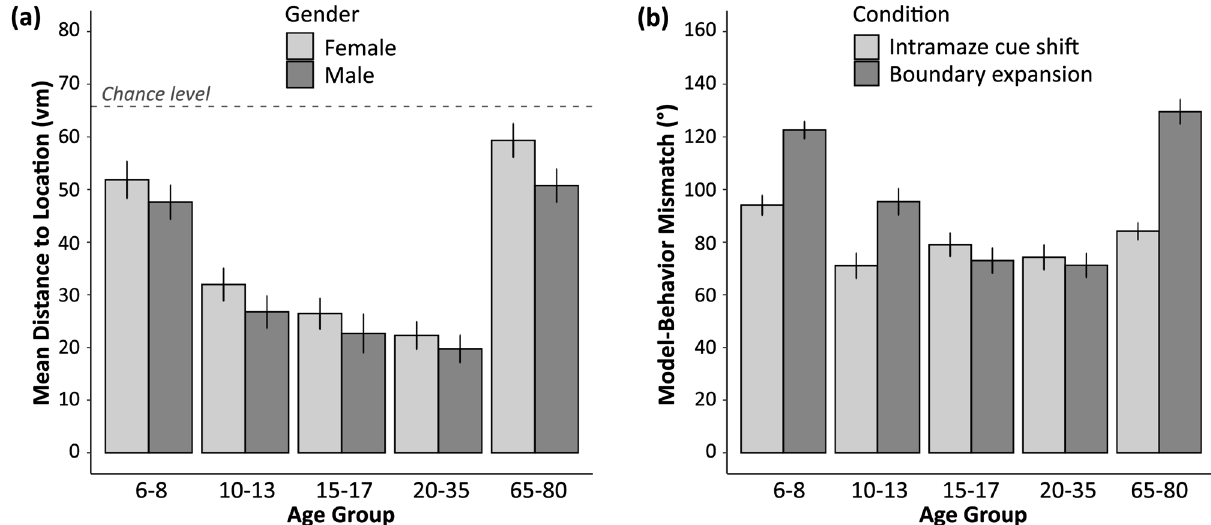
Figure 2. Differential age differences in spatial navigation performance across the lifespan. ( a ) Mean distance between the actual and the memorized object positions during the learning with feedback phase for all five age groups (compared to chance baseline) separated by gender (higher values indicate larger distance errors during spatial learning and memory). ( b ) Angle deviation i.e., mismatch between model predicted and observed behavior in both conditions of the transfer phase (larger angle deviations indicate less intramaze cue- or boundary-based learning during spatial navigation and angles between 90–180° indicate that the model- predicted and the observed vectors point into opposite directions i.e., model-prediction and observed behavior diverge more strongly). Error bars indicate one standard error of the